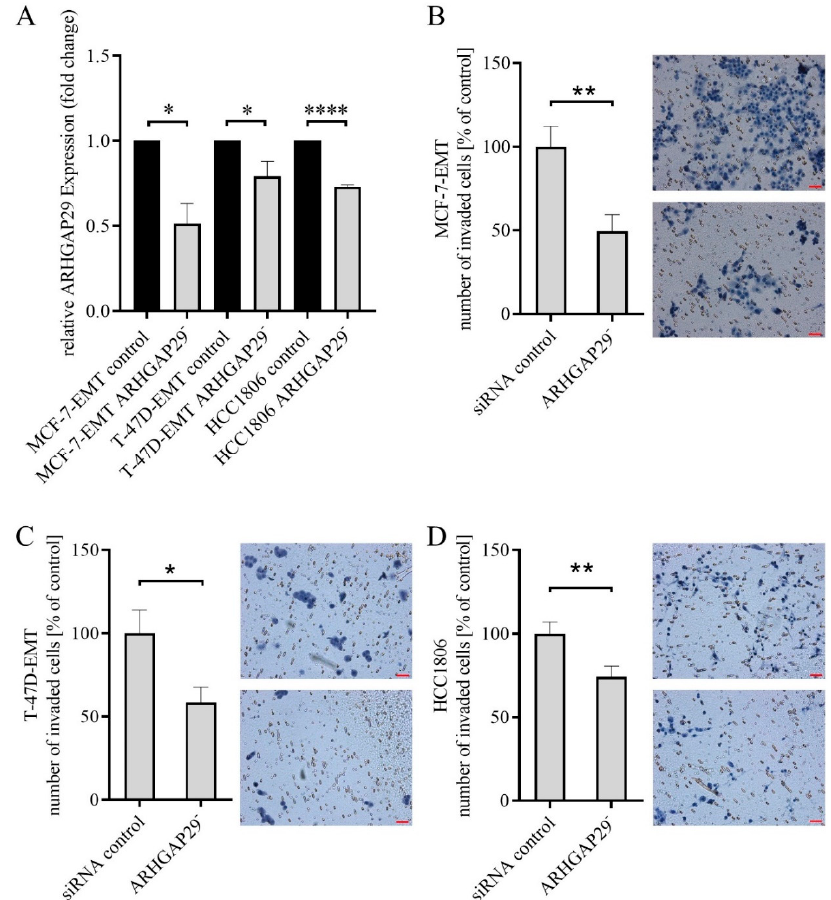
Figure 2. ( A ) Detection of reduced Rho GTPase activating protein 29 (ARHGAP29) expression after transient siRNA transfection of MCF-7-EMT, T-47D-EMT, and HCC1806 breast cancer cells.